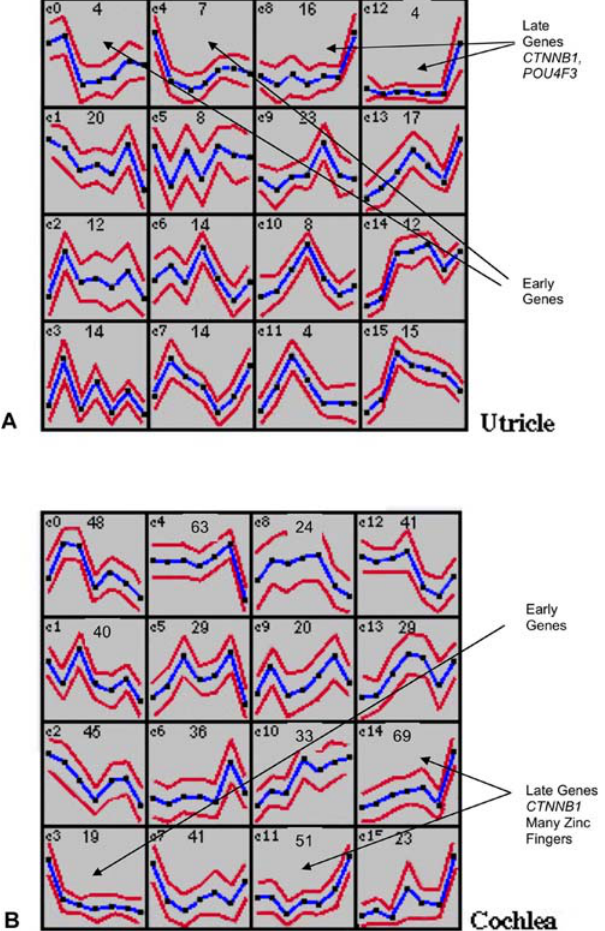
Figure 3. Analysis of the datasets by Self Organizing Maps. All of the differentially expressed genes listed in Supplementary Tables S2, S4, S6 and S8 were uploaded into Genecluster 2 and 16 centroids per organ were generated. Each box (centroid) in this figure is numbered from C0–C15 and they reflect common patterns of expression for clustered groups of genes within the dataset. The X-axis for each centroid consists of each time point and runs from the laser 30 min time point through 1 hr, 2 hrs, 3 hrs and then into the neomycin 0 time point followed by the neomycin 24 and 48 hr time points. The Y-axis indicates expression level (fold-change). The number in the top left of each centroid indicates the number of genes that fall into this cluster of co- expression. The top line indicates the upper boundary of expression for all of these genes and the lower line indicates the lower boundary. The middle line is the mean. All of the specific genes that fall into each centroid are listed in Supplementary Tables S18 and S19. Figure 3A shows the clustering for the utricle time points and Figure 3B shows the clustering for cochlea time points. Arrows indicate various patterns or genes within specific centroids that are described in the